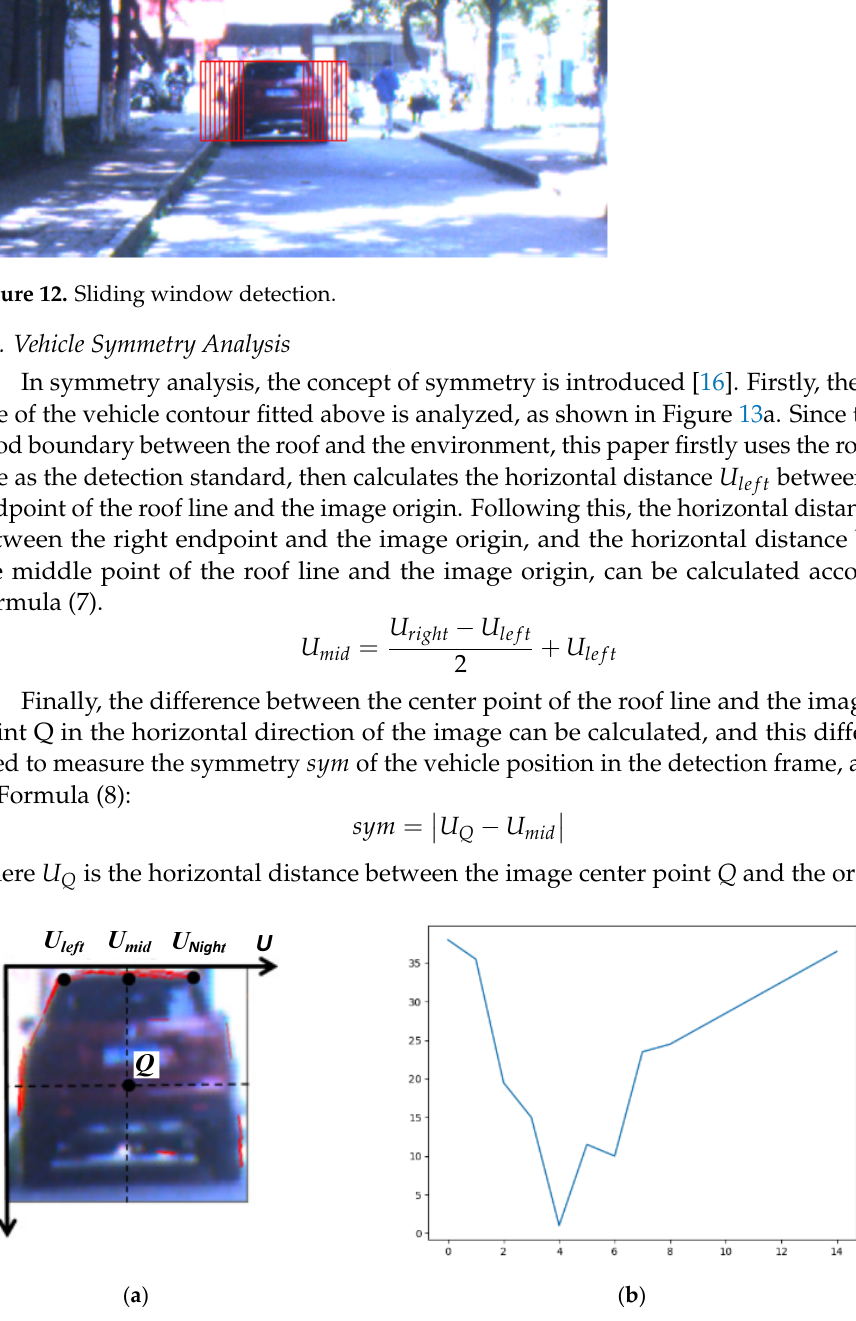
Figure 14. Calibration of the camera’s internal parameters. After the camera’s internal parameter calibration, the external parameter matrix of the camera and the radar can be calculated by using a laser rangefinder to measure the vertical and horizontal distances between the radar and the camera, and at the same time, measure the height of the radar from the ground. Table 1 shows the external pa- rameter calibration of the camera. The transformation of different spaces can be realized according to the camera’s internal parameters, rotation matrix, and translation matrix. Table 1. Calibration table of camera parameters. Calibration Parameters camera’s internal parameters